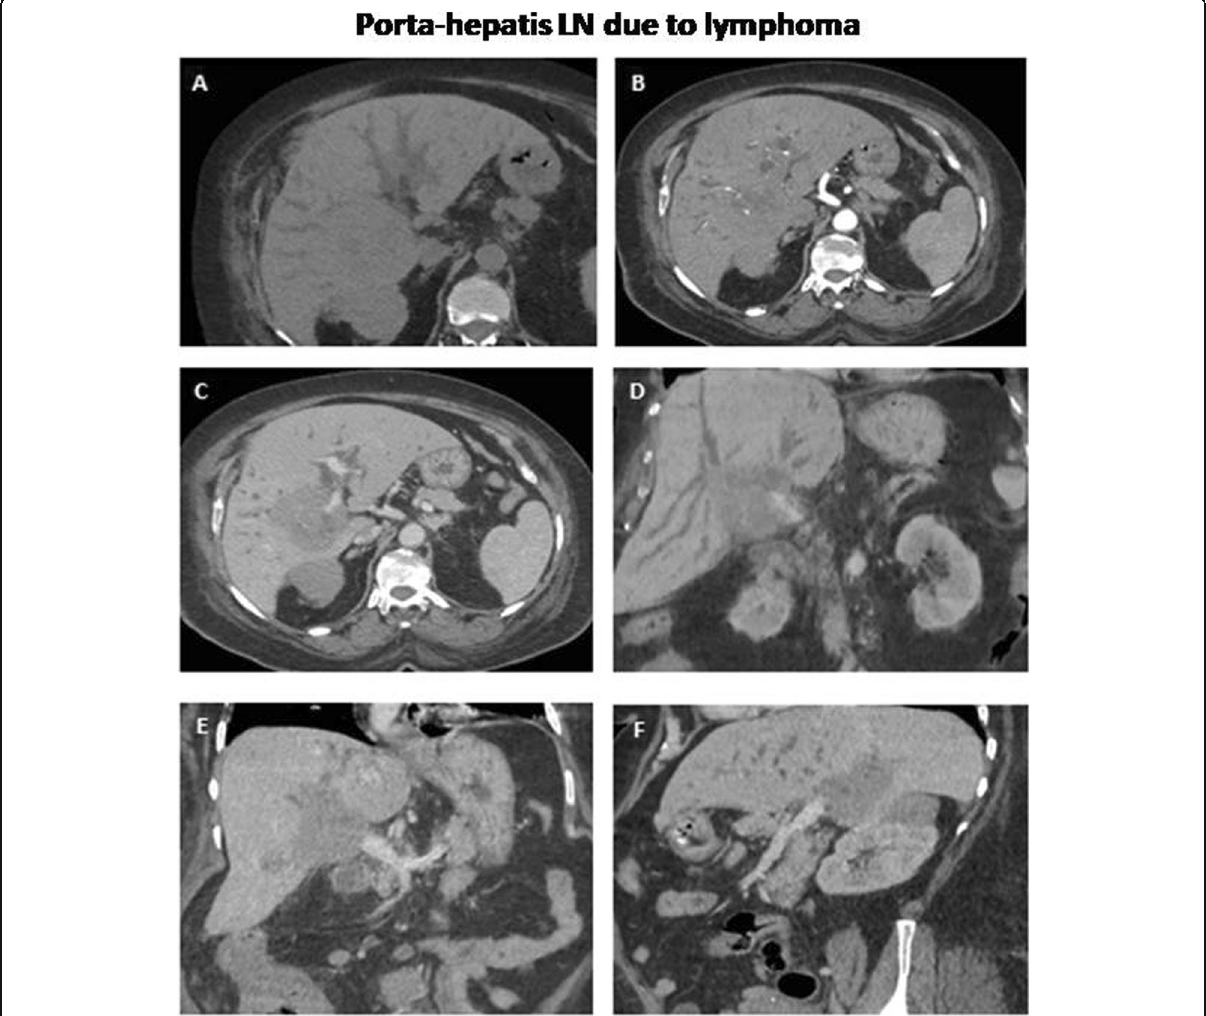
Fig. 6 Portahepatis LN due to lymphoma. Malignant obstructive jaundice due to soft tissue mass lesion involving portahepatis LNs of lymphoma. Male patient, 75 years old, presented with dark urine, pale stool, and jaundice. a Axial pre-contrast image showing moderate intra-hepatic biliary radical dilatation. b , c Axial contrast (arterial and portal phase) images showing large ill-defined faintly enhanced soft tissue density mass lesion involving the portahepatis region centered at the confluence of the RT and LT hepatic ducts and encroaching upon the right PV branch. d Coronal oblique MinIP reformatted MDCT cholangiography showing the mass at the portahepatis with its consequent moderate IHBRD. e , f Coronal and sagittal oblique reformatted MDCT cholangiography images showing the soft tissue lesion involving the portahepatis